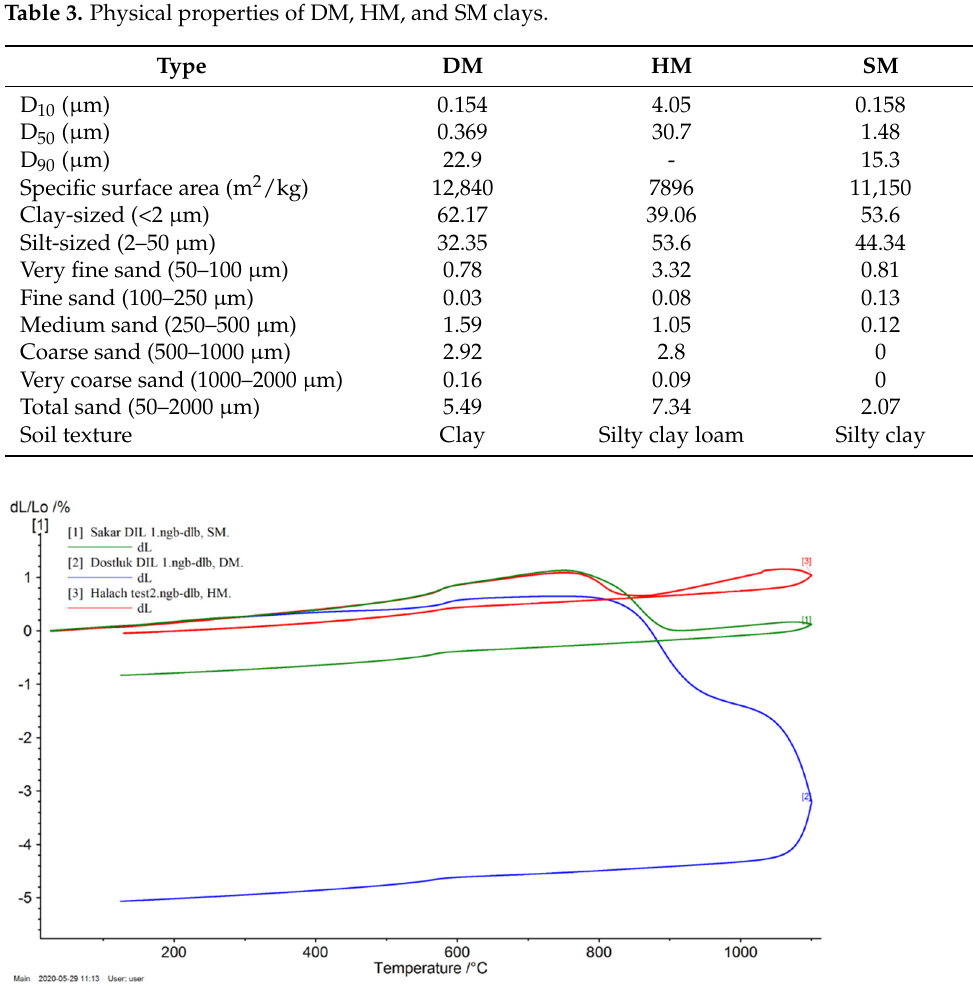
Figure 4. Dilatometric curves for DM, HM, and SM brick specimens fired at 1100 °C . Legends: [1] or green line, [2] or blue line and [3] or red line represents SM, DM and HM, respectively.